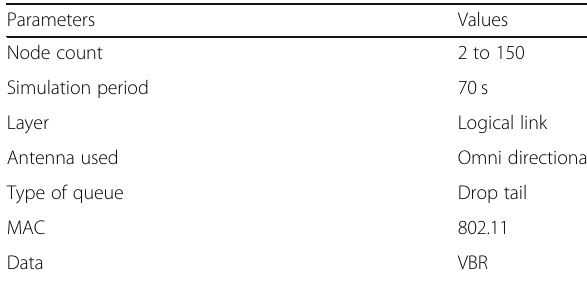
Table 1 Parameters for simulation